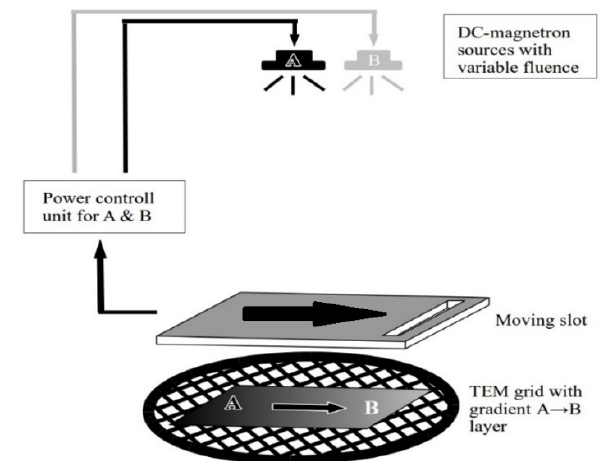
Figure 3. Setup of the synthesis of a micro-combinatorial TEM sample. The concentration-spread layer is deposited from DC magnetron sources A and B through a moving slit onto the TEM grid. The output power of the two sources is adjusted in accordance with the moving slit to obtain a strip of a 3-stage sample: pure A, gradient A ➩ B, and pure B.